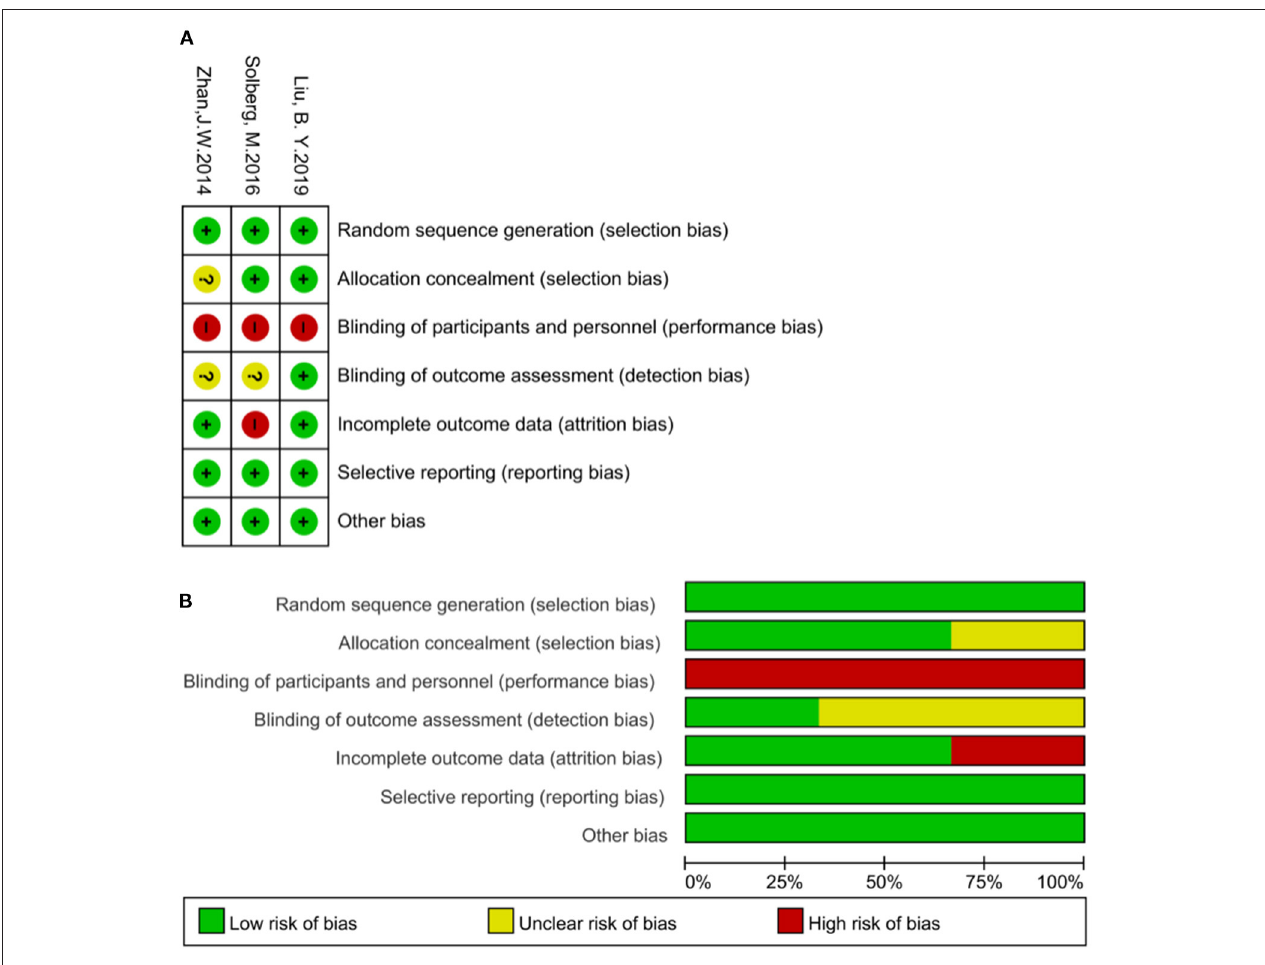
FIGURE 1 | (A) Risk of bias summary: review authors’ judgements about each risk of bias item for each included study. (B) Risk of bias graph: review authors’ judgements about each risk of bias item presented as percentages for all included